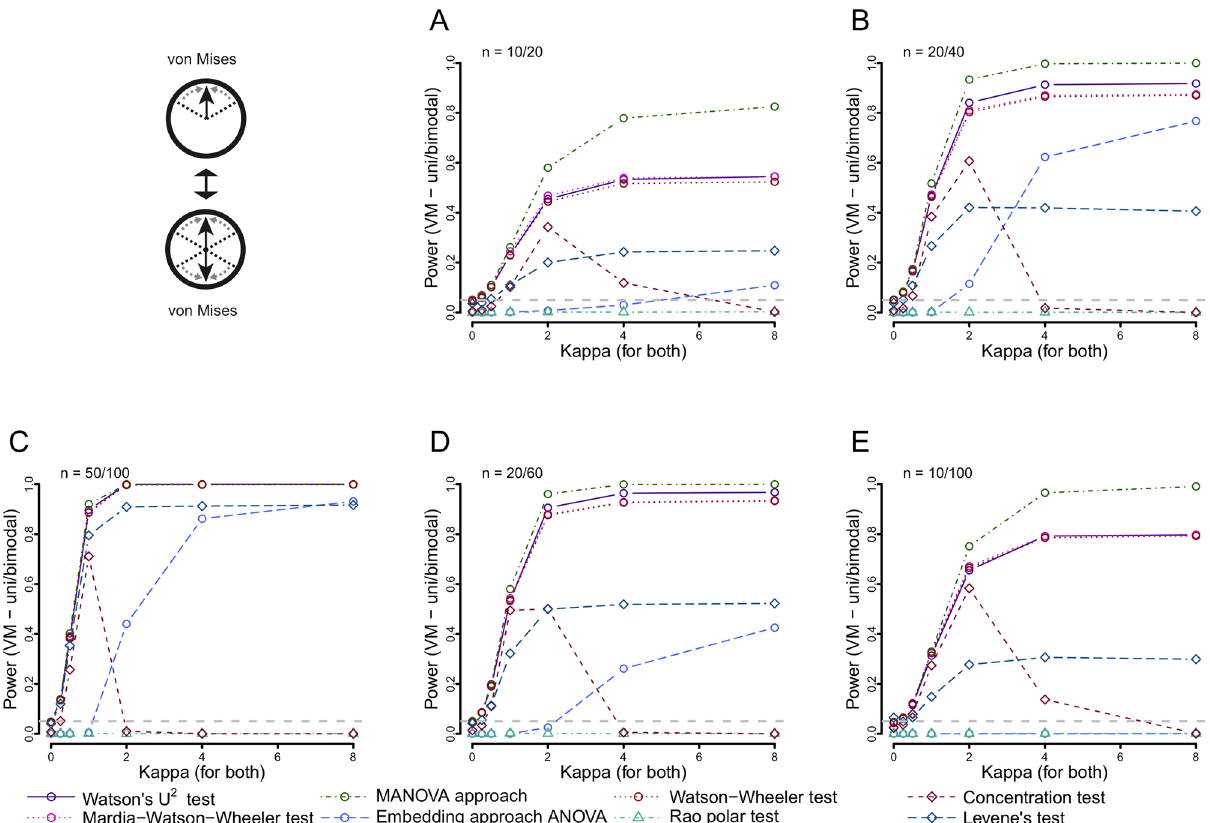
Figure 5. Power of all included tests when comparing von Mises distributions of differing number of modes (unimodal and axially bimodal) using different sample sizes: 10 and 20 ( A ), 20 and 40 ( B ), 50 and 100 ( C ), 20 and 60 ( D ) and 10 and 100 ( E ). The concentration (κ) of both increases from 0 to